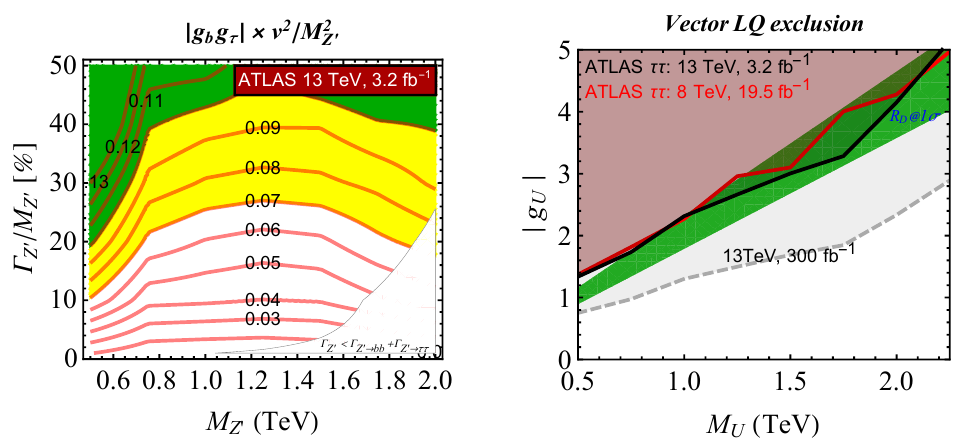
Figure 3: (left plot) 13 TeV exclusion limits on the b ¯ b → Z (cid:48) → ττ resonance at 3.2 fb − 1 . Isolines shown in red represent upper limits on the combination = | g g g τ |× v 2 / M 2 as a function of the Z (cid:48) mass and total width. The R V L b Z (cid:48) regions at 68% and 95% CL are shaded in green and yellow, respectively. (right plot) 8 TeV (13 TeV) ATLAS τ ¯ τ search exclusion limits are shown in red (black) and R preferred region in green for the vector LQ model. Here the coupling is defined by ≡ x b τ g . Projected 13 TeV limits for 300 fb − 1 are shown in U L